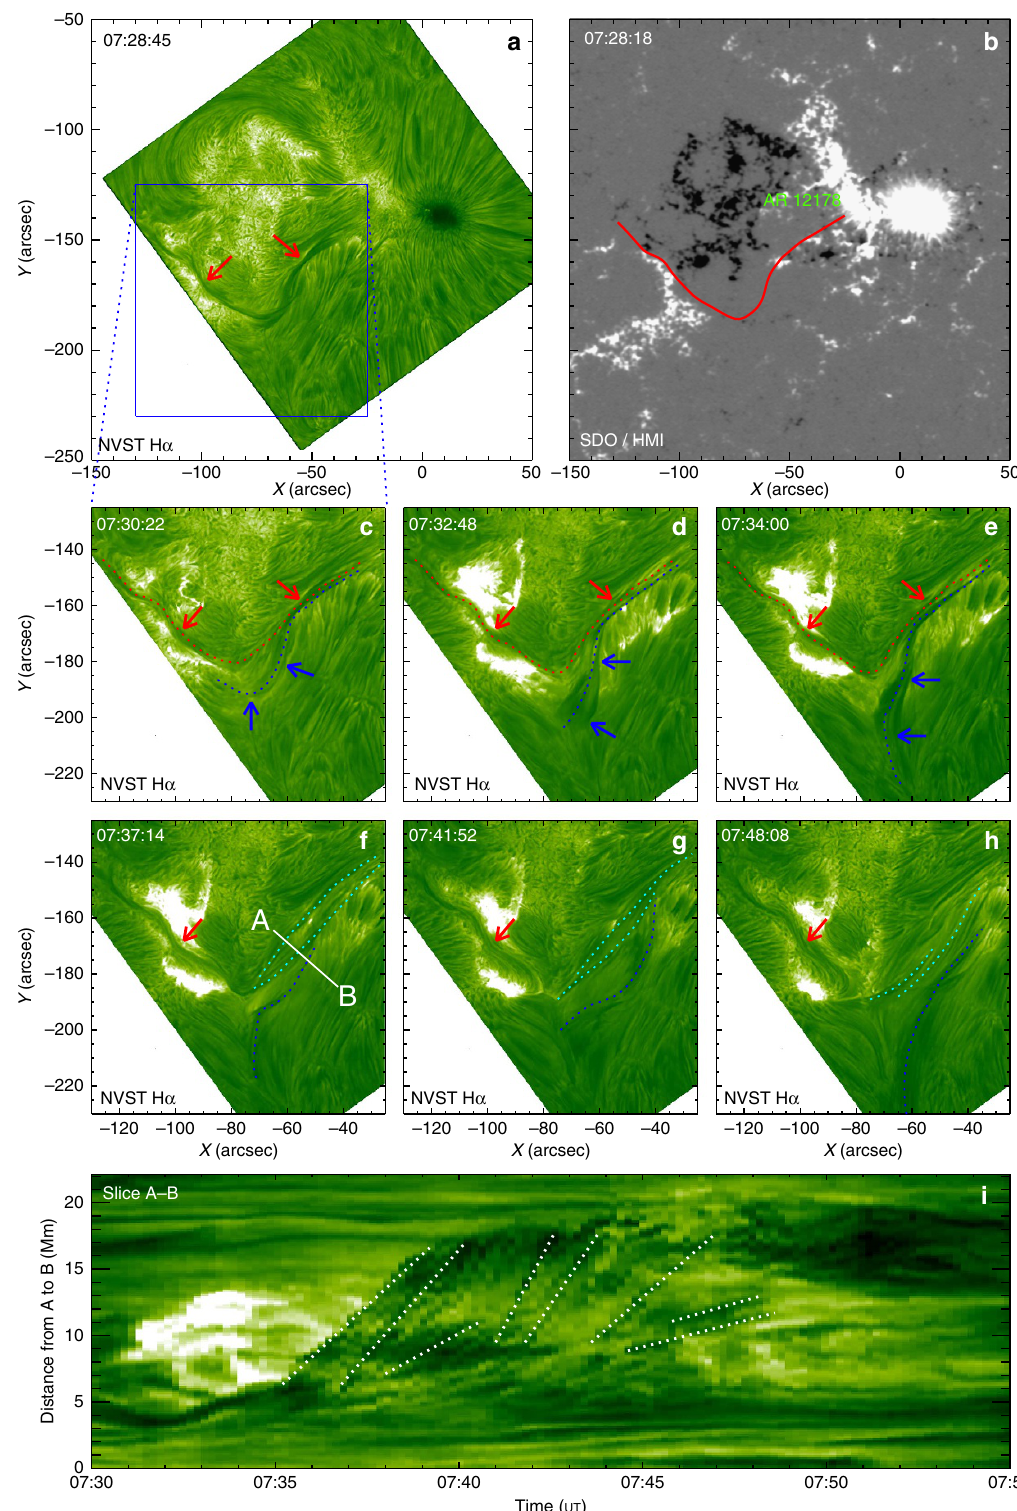
Figure 1 | Structure and eruption of the filament. ( a ) NVST H-alpha image showing the general appearance of the filament (indicated by the red arrows) at the onset of the eruption. ( b ) HMI line-of-sight magnetogram of AR 12178, with positive (negative) photospheric flux shown in white (black) and the red line representing the position of the filament. ( c – h ) The process of filament eruption in H-alpha images. The original position is marked by the red-dotted line. The erupting part is indicated by the blue-dotted lines and blue arrows. Cyan-dotted lines in f – h indicate some of the filament threads that rise with a delay. The stable eastern filament section is marked by the red arrows in f – h . ( i ) Time-slice plot acquired at the position A–B, with the white-dotted lines marking the filament threads. The motion of these threads indicates the untwisting of the filament during its